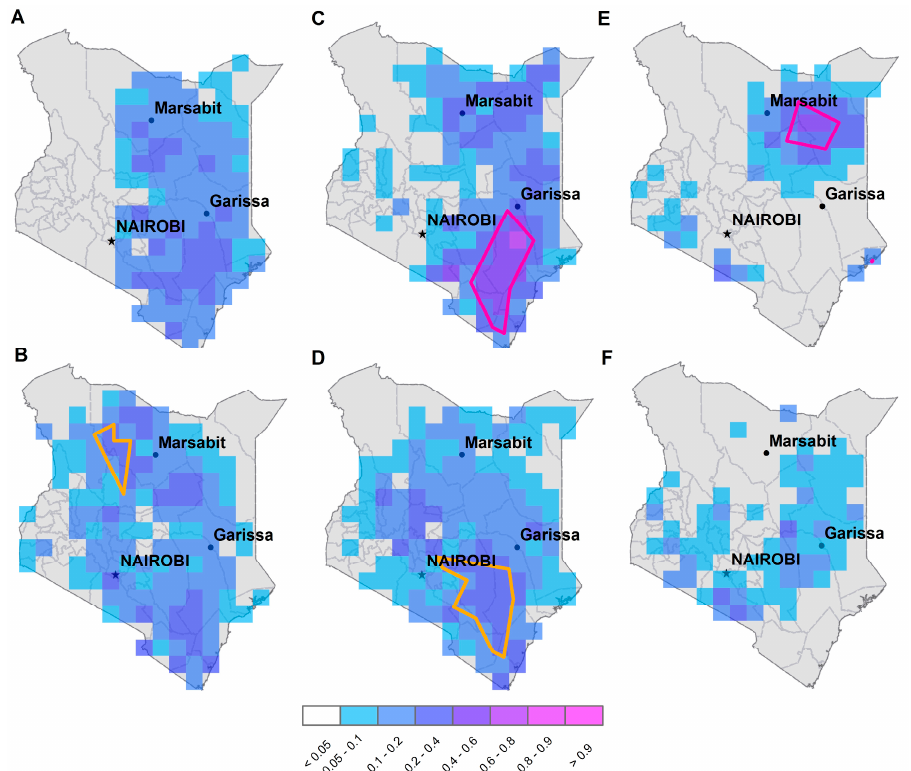
Figure 16. Multi-model ensemble gridded forecast probabilities of extreme daily rainfall (i.e., rainfall exceeding the 99 th percentile of the climatological distribution) from the Global Hazard Map (GHM) (top row: three-day lead time; bottom row: six-day lead time) for specific days with the P1–P3 rainfall events (left to right columns). Specifically, for 4 March (P1 event) from forecasts initialized ( A ) 28 February 2018 12UTC and ( B ) 25 February 2018 12UTC; for 16 March 2018 (P2 event) from forecasts initialized ( C ) 13 March 2018 12UTC and ( D ) 10 March 2018 12UTC; for 14 April 2018 (P3 event) from forecasts initialized ( E ) 11 April 2018 12UTC and ( F ) 8 April 2018 12UTC. Pink summary polygons shown in ( C , E ) represent the area where the forecast probabilities exceed the specific three-day lead time probability threshold (0.32), while the orange summary polygons shown in ( B , D ) represent the area where the forecast probabilities of the exceed the specific six-day lead time probability threshold (0.22). These polygons as illustrated are a feature of the GHM seven-day summary display, and are drawn when the probability of exceeding the 99 th percentile is above a lead-time-varying threshold.